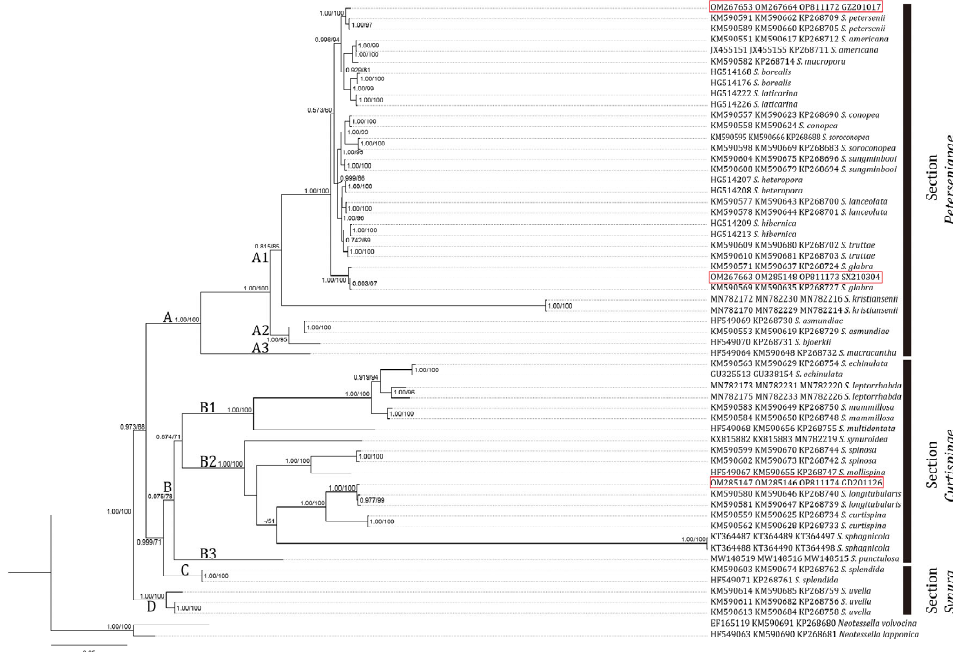
Figure 2. Bayesian inference (BI) tree based on concatenated SSU, LSU, and ITS sequences. Support values > 50% for all analyses are shown as follows: Bayesian posterior probabilities (BI)/maximum likelihood bootstrap values (ML). ‘-’ denotes < 50% support for that analysis at that node. Red boxes indicate the Synura specimens used in this